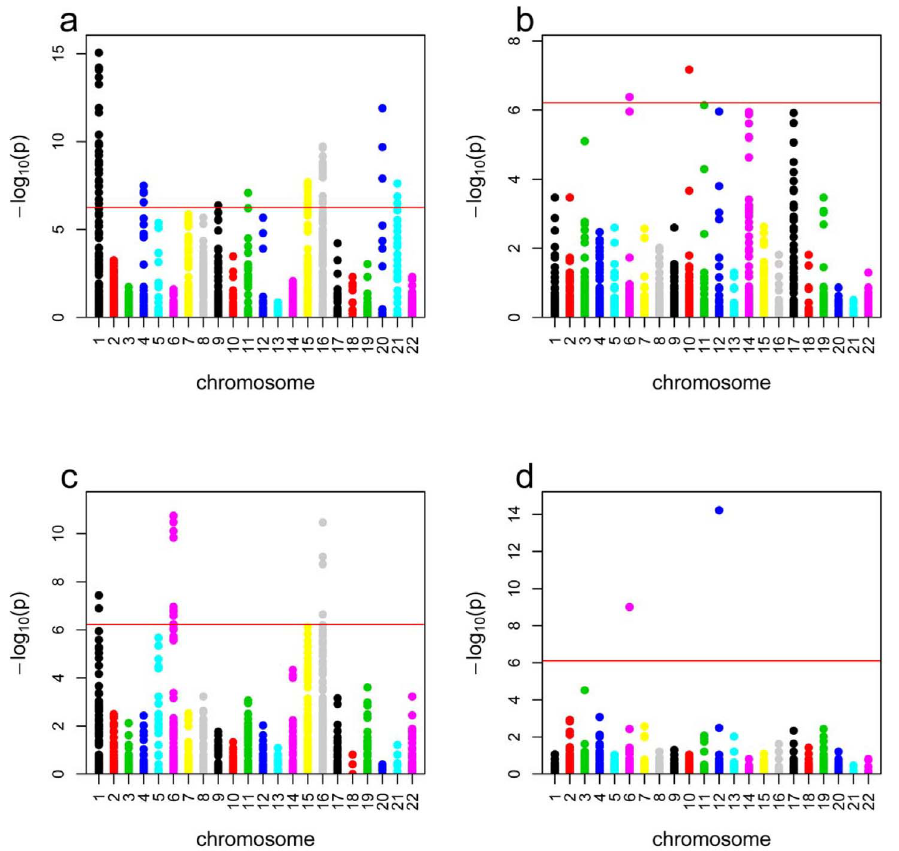
Figure 1. Plot of CNVR association with BAVM from the segment-based analysis. Chromosomes and -log p-values of CNVR association with BAVM are shown on the x and the y axes; respectively. The red horizontal line corresponds to the genome wide significance threshold corrected for multiple testing using the Bonferroni procedure. a . Duplications using PennCNV, b . Deletions using PennCNV, c . Duplications using Birdsuite. d . Deletions using Birdsuite.